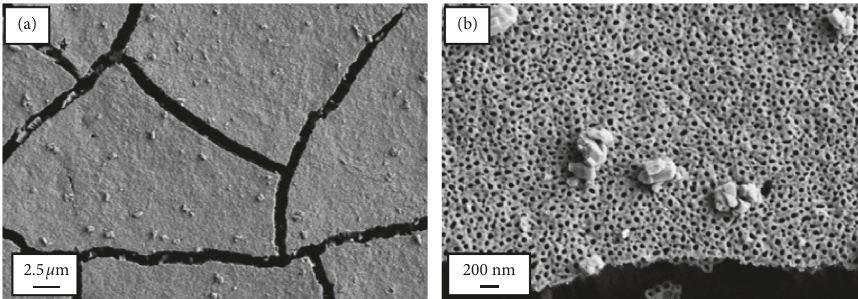
Figure 1: SEM micrographs of TiO 2 NT disks mixed with HAp solution and rinsed in water at (a) low and (b) high magnification.